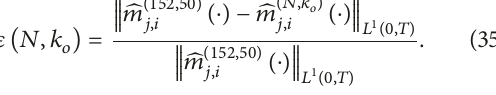
Figure 6: Current time and shifted future time trajectories of the forced vdP oscillator for 𝑘 = 0 , 𝑘 𝑜 = 10 , and 𝑁 = 102